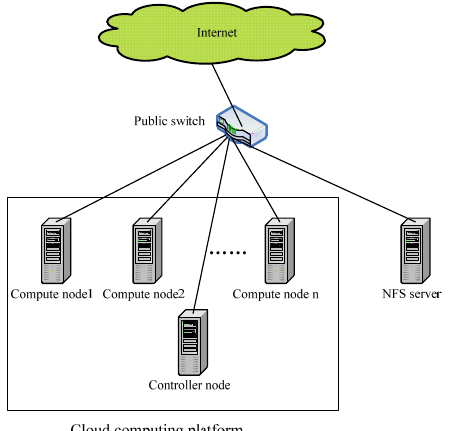
Figure4. The physical architecture of private cloud